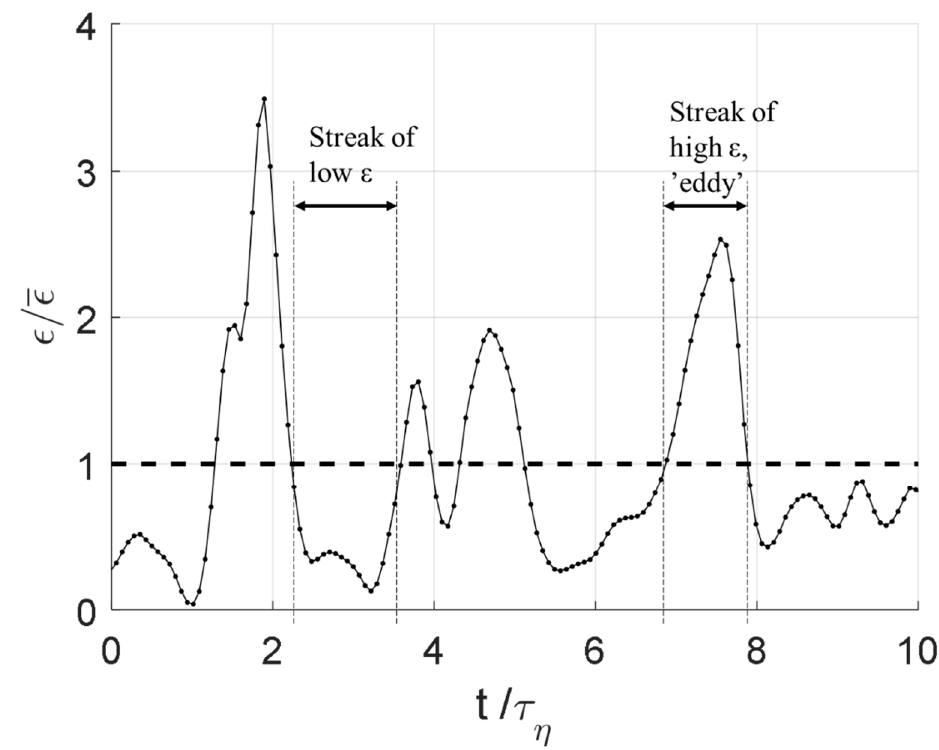
Figure 1. The instantaneous dissipation rate of TKE ( ε ), as a function of time ( t ) in a pipe flow at a position in the proximity of the wall ( y + = 90). The horizontal axis is normalized by the time-averaged value, ε (obtained over a time substantially longer than the displayed interval) and the horizontal axis is normalized with the Kolmogorov time-scale, τ η . (Calculated based on DNS-generated raw data for a turbulent channel with a bulk Reynolds number of 40,000 from the John Hopkins Turbulence Database, DOI: